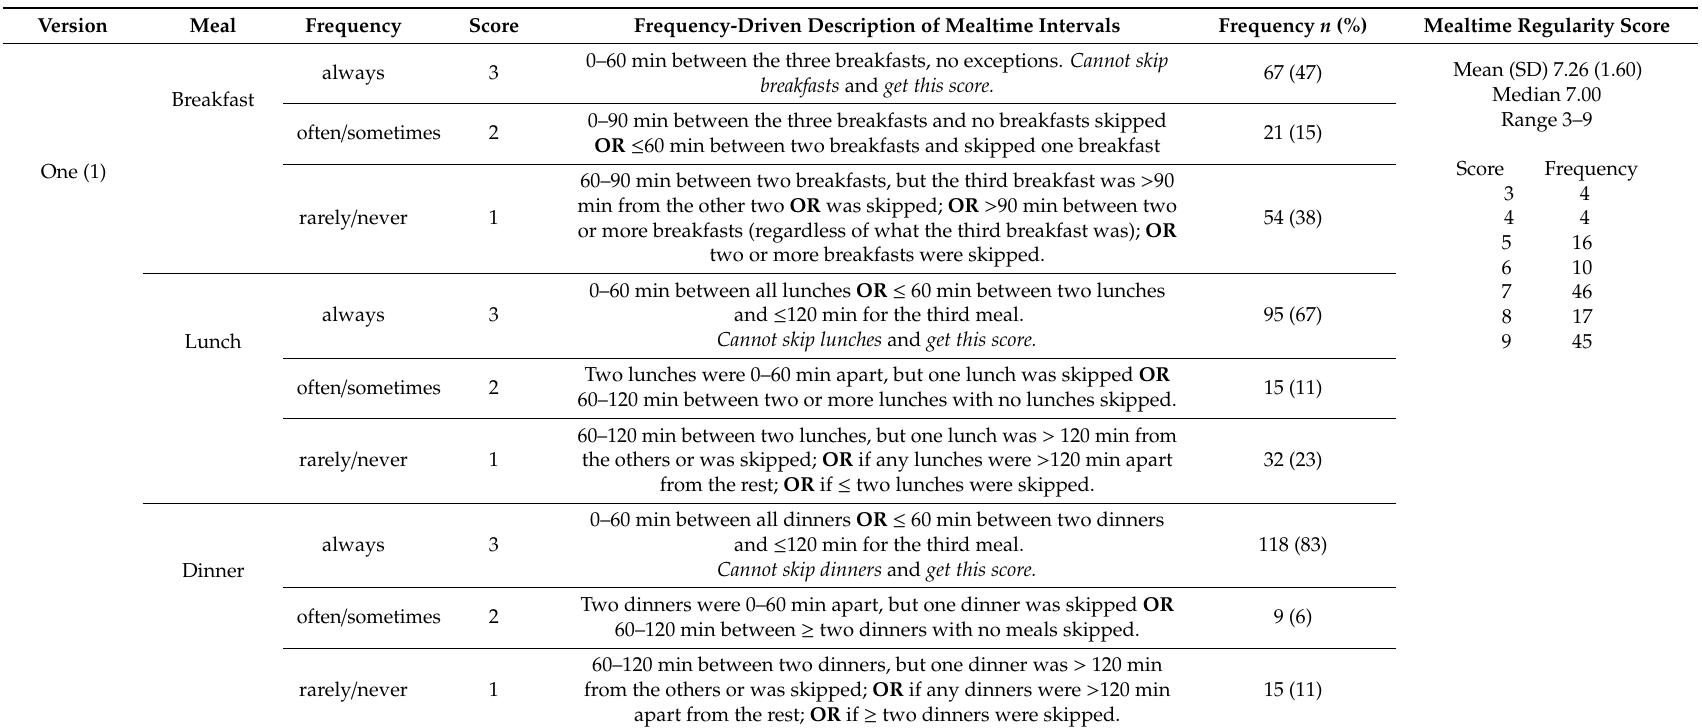
Table 1. Mealtime regularity scoring protocol and outcomes for three meal and temporally specific versions based on three 24-h dietary recalls of parents with children participating as 4th graders in Fuel for Fun ( n =